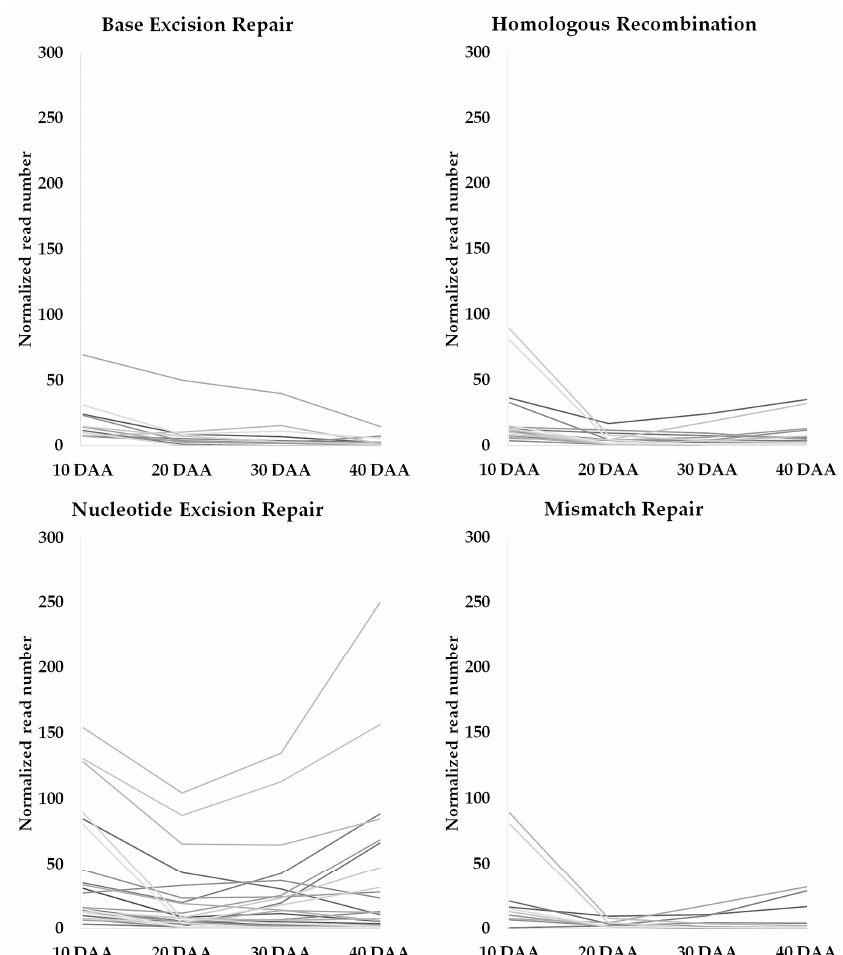
Figure 3. Profiles of expressed genes related with different DNA repair mechanisms (classification based on description made by Sampinato [4]). DAA: days after anthesis. Grey lines depict expression profiles for each individual gene in the DNA repair mechanisms.